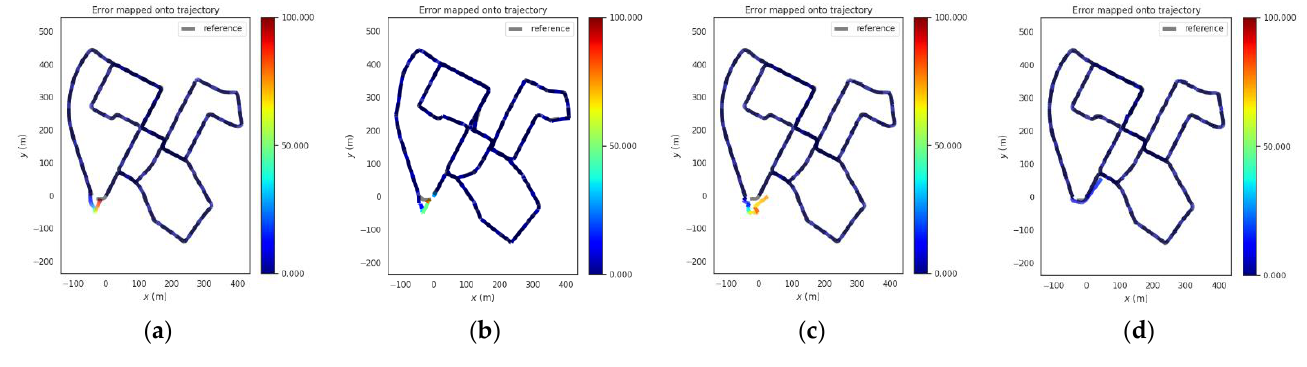
Figure 17. Trajectories of the four methods in urban scene. ( a ) GNSS, ( b ) VINS-Fusion, ( c ) PTC-SLM- Forward, ( d ) PTC-SLM. Forward, ( d ) Table 8. Error parameters of the four methods in urban scene.